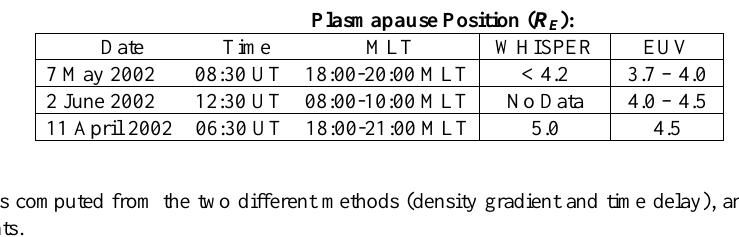
Table 4. Normal directions computed from the two different methods (density gradient and time delay), and projected normal boundary velocities for the three